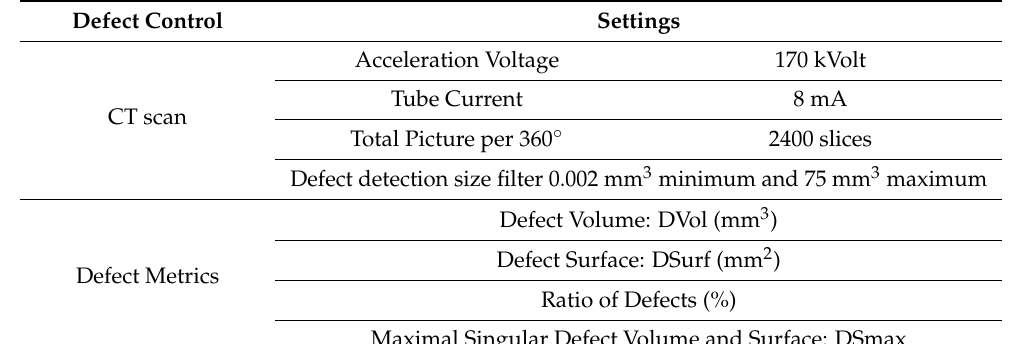
Table 1. Alloy production Experiment Parameters . Table 2. Defect Evaluation